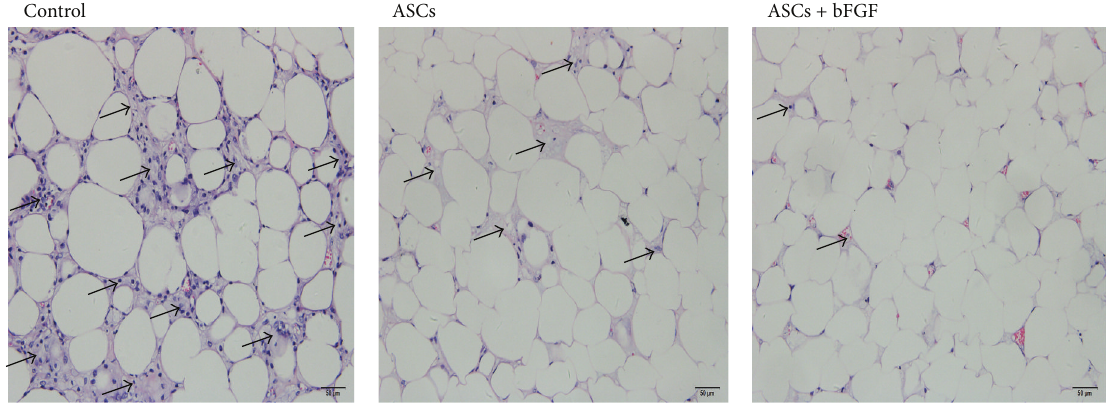
Figure 2: HE stain evaluation of fat grafts (magnification × 200). The control grafts exhibited excessive fibrosis (shown as ↑ ); in the group with ASCs, the grafts consisted predominantly of mature lipocyte and had significant lower levels of fibrosis; and bFGF ameliorated fibrosis